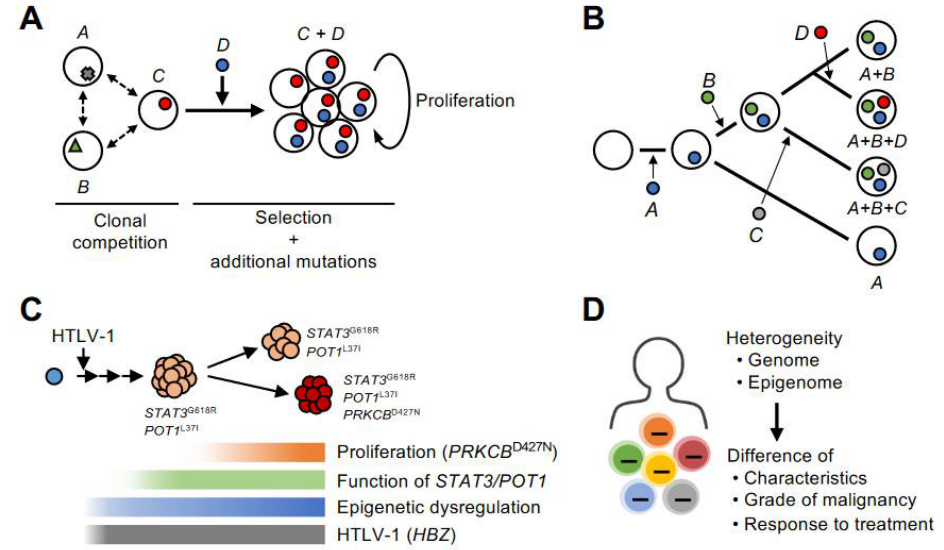
Figure 3. Clonal evolution mechanism by genome and epigenome. ( A ) In a heterogeneous population consisting of cells with various abnormalities, the clone with the greater dominance is selected through a clonal competition. ( B ) Infected clones evolve and adapt to their environment by acquiring genetic mutations in a stepwise manner during clonal selection. ATL is a monoclonal malignancy in which a single infected cell has evolved through a multistep process. However, the tumor cell population is not homogeneous at the genome, epigenome, and other properties, but is composed of diverse subclones. ( C ) This schematic model provides an example of the evolutionary process to acute-type ATL. In this case, the emergence of a high-grade clone that acquired the PRKCB mutation led to the development of acute type disease. The effect of genetic abnormality is expressed as a gene expression pattern in each subclone. The accumulation of H3K27me3 acquired before the subclonal formation and the associated expression abnormalities are detected as common characteristics in the subclones. ( D ) Genomic and epigenomic heterogeneity is reflected in differences in the characteristics of infected and tumor cells, their grade of malignancy, and their responsiveness to therapy.